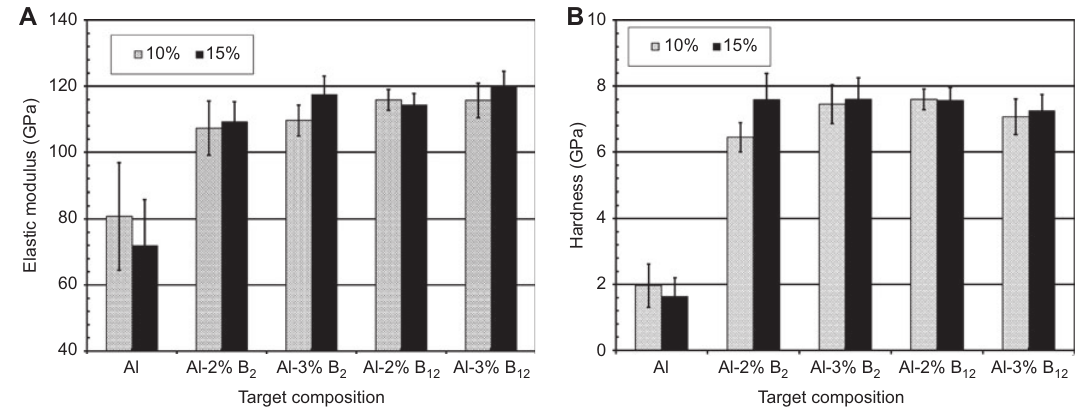
Figure 9 Nanoindentation results: (A) elastic modulus; (B)